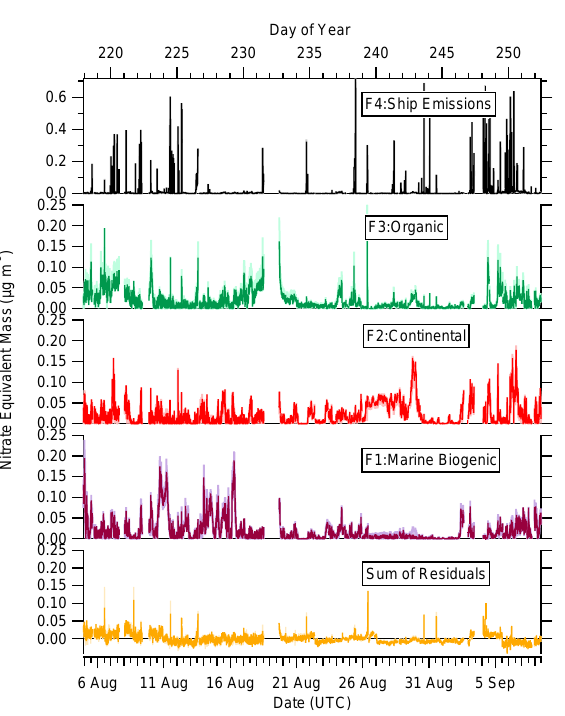
Fig. 3. Time series of the PMF factors when performed on the entire mass spectrum. The solid trace is the solution for an fPeak of -0.75 and the shaded regions the range for fPeaks of − 1 . 5 to